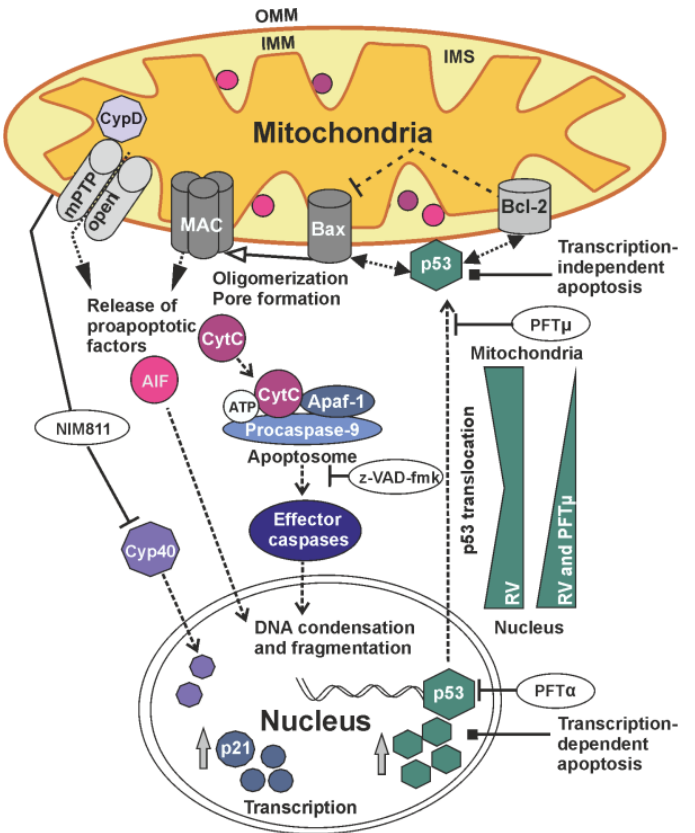
Figure 9. Proposed model for the involvement of mitochondria- and p53-associated pathways during RV-induced cell death. The transcription-independent mitochondrial p53 function can be blocked by PFTμ. p53 can interact with the pro-apoptotic protein Bax to induce its oligomerization and formation of the mitochondrial apoptosis-induced channel (MAC). The release of pro-apoptotic CytC promotes the formation of the so-called apoptosome consisting of apoptotic protease-activating factor (Apaf-1), pro-caspase 9 and CytC. Effector caspases can be inhibited by the pan-caspase-inhibitor z-VAD-fmk. Application of NIM811 can inhibit cyclophilins such as CypD and Cyp40 as examined in this study. Further explanations are provided in the manuscript. IMS, mitochondrial intermembrane space.